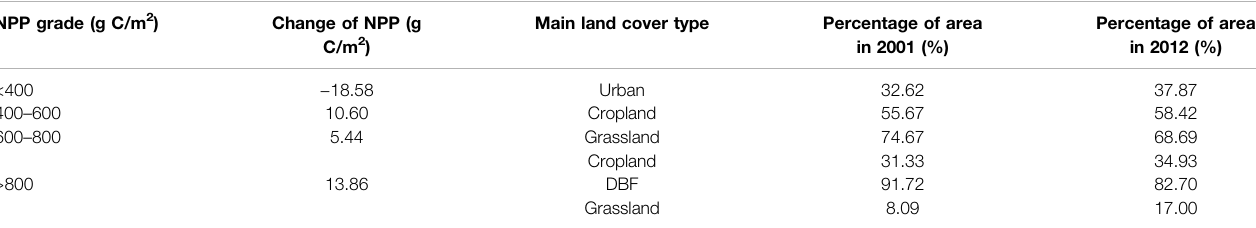
TABLE 3 | Change of NPP for the four